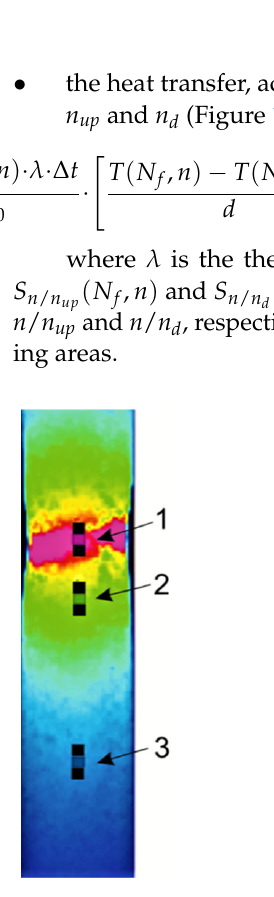
Figure 11. Neighboring areas n up and n d of sections 1, 2, and 3.